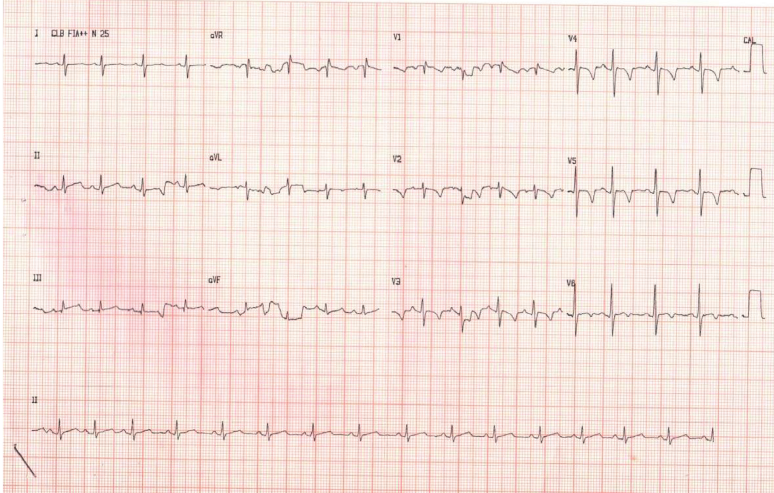
Figure 2: Electrocardiogram depicting electrocardiographic